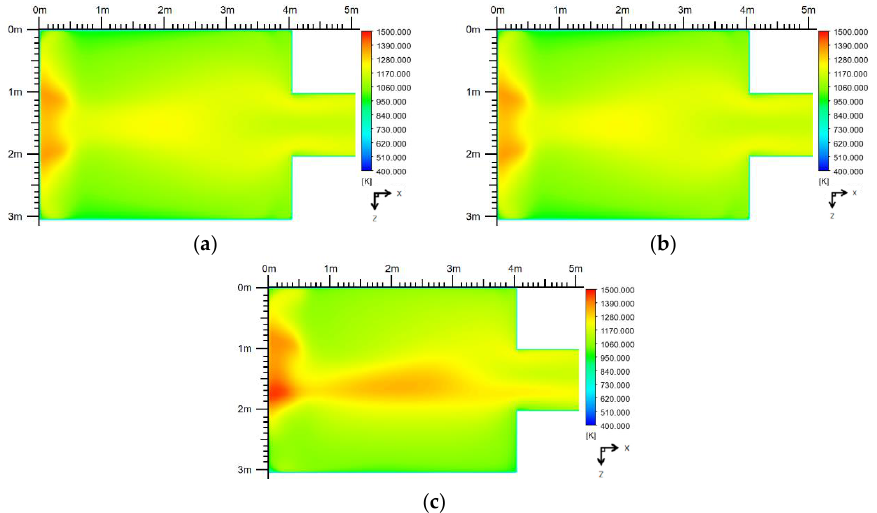
Figure 8. Temperature cloud diagram of central cross-section of the second combustion chamber (Y = 2.35 m). ( a ) Symmetrical arrangement of burners with reverse swirl; ( b ) symmetrical arrangement of burners with same direction flow; ( c ) burner-staggered arrangement with same direction flow.